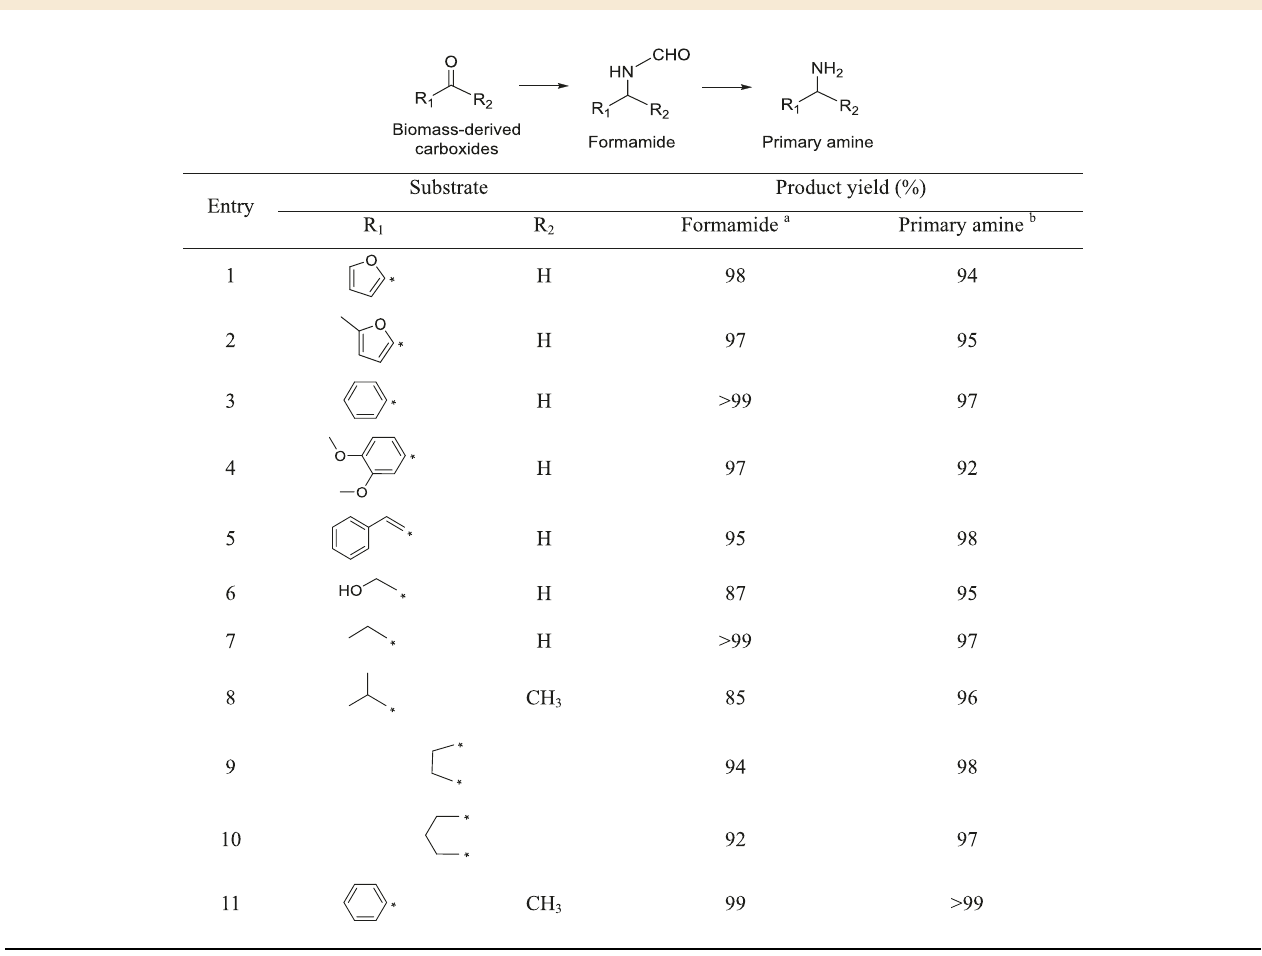
Table 2 Selective production of formamides and primary amines from